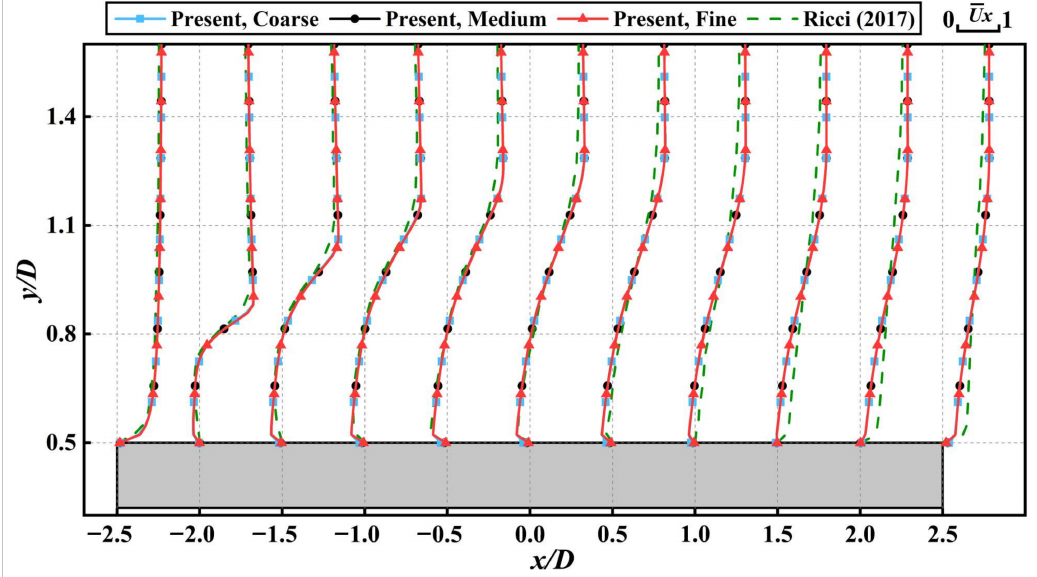
Figure 5. Time-averaged velocity distribution profile near the